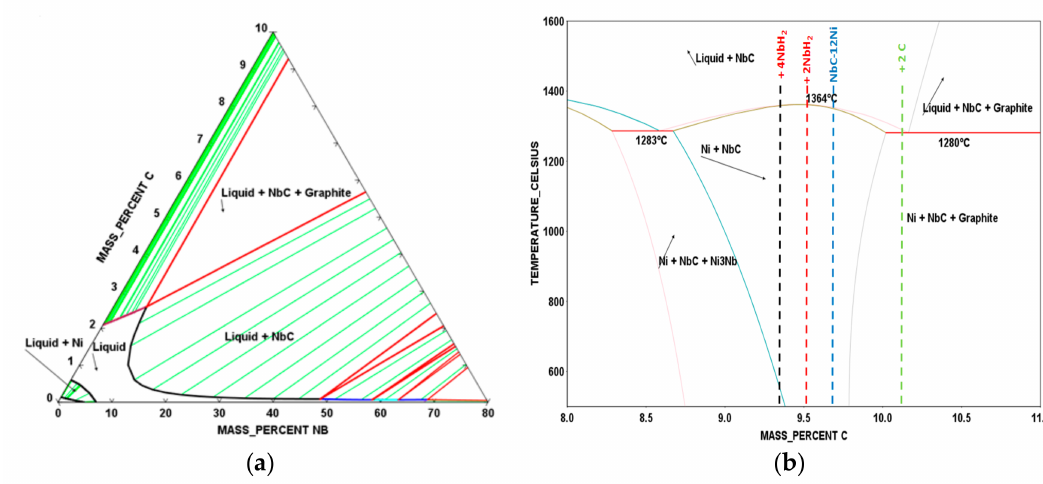
Figure 4. Calculated isothermal section of Ni-Nb-C system at 1420 ◦ C ( a ) and influence of the C content on the phase relation of the Nb-C-12 vol % Ni system ( b